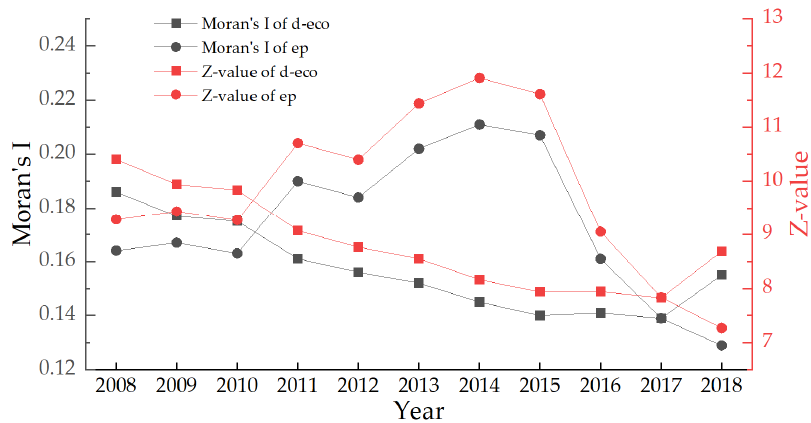
Figure 5. Global spatial evolution of digital economy and environmental pollution in China.